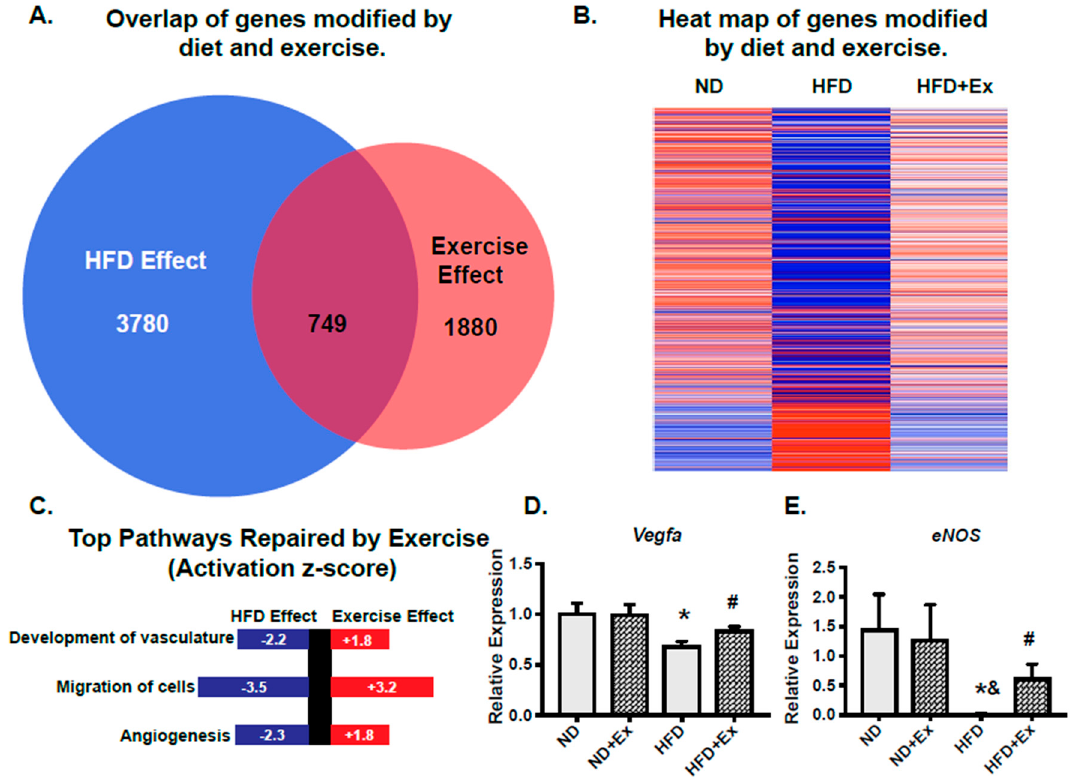
Figure 3. Exercise rescues HFD scWAT transcriptomic pathways involved in